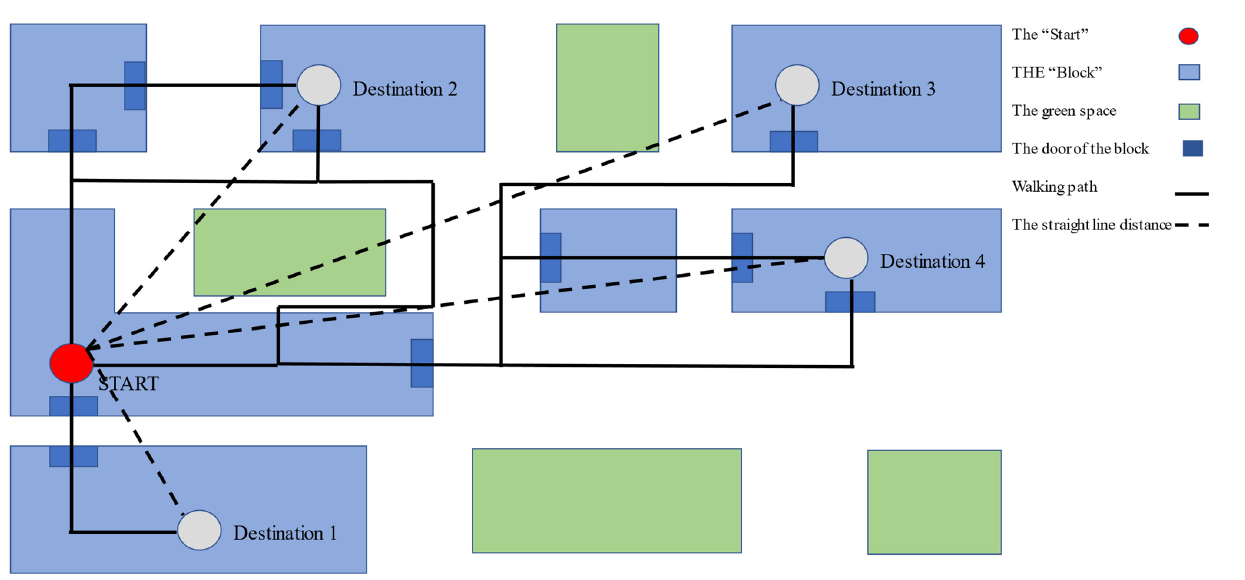
Figure 2. Mathematical Model of Street Connectivity Measurement.